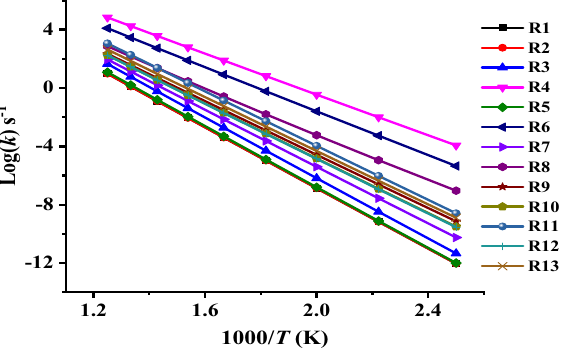
Figure 9. RRKM rate constants for unimolecular decomposition reactions of the investigated ethoxyquinolines and ethoxyisoquinolines (R1–R13) at ( T = 400–1200 K, p = 1 atm) calculated at CBS-QB3//BMK/6–31+G(d,p) level.